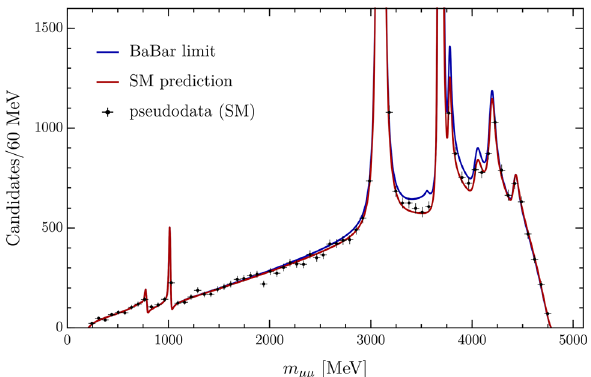
Fig. 3 Example pseudodata expected from the full run II dataset col- lected by the LHCb experiment assuming the SM. The distribution expected if the B + → K + τ + τ − branching fraction were present at the current experimental limit of 2 . 25 × 10 − 3 is